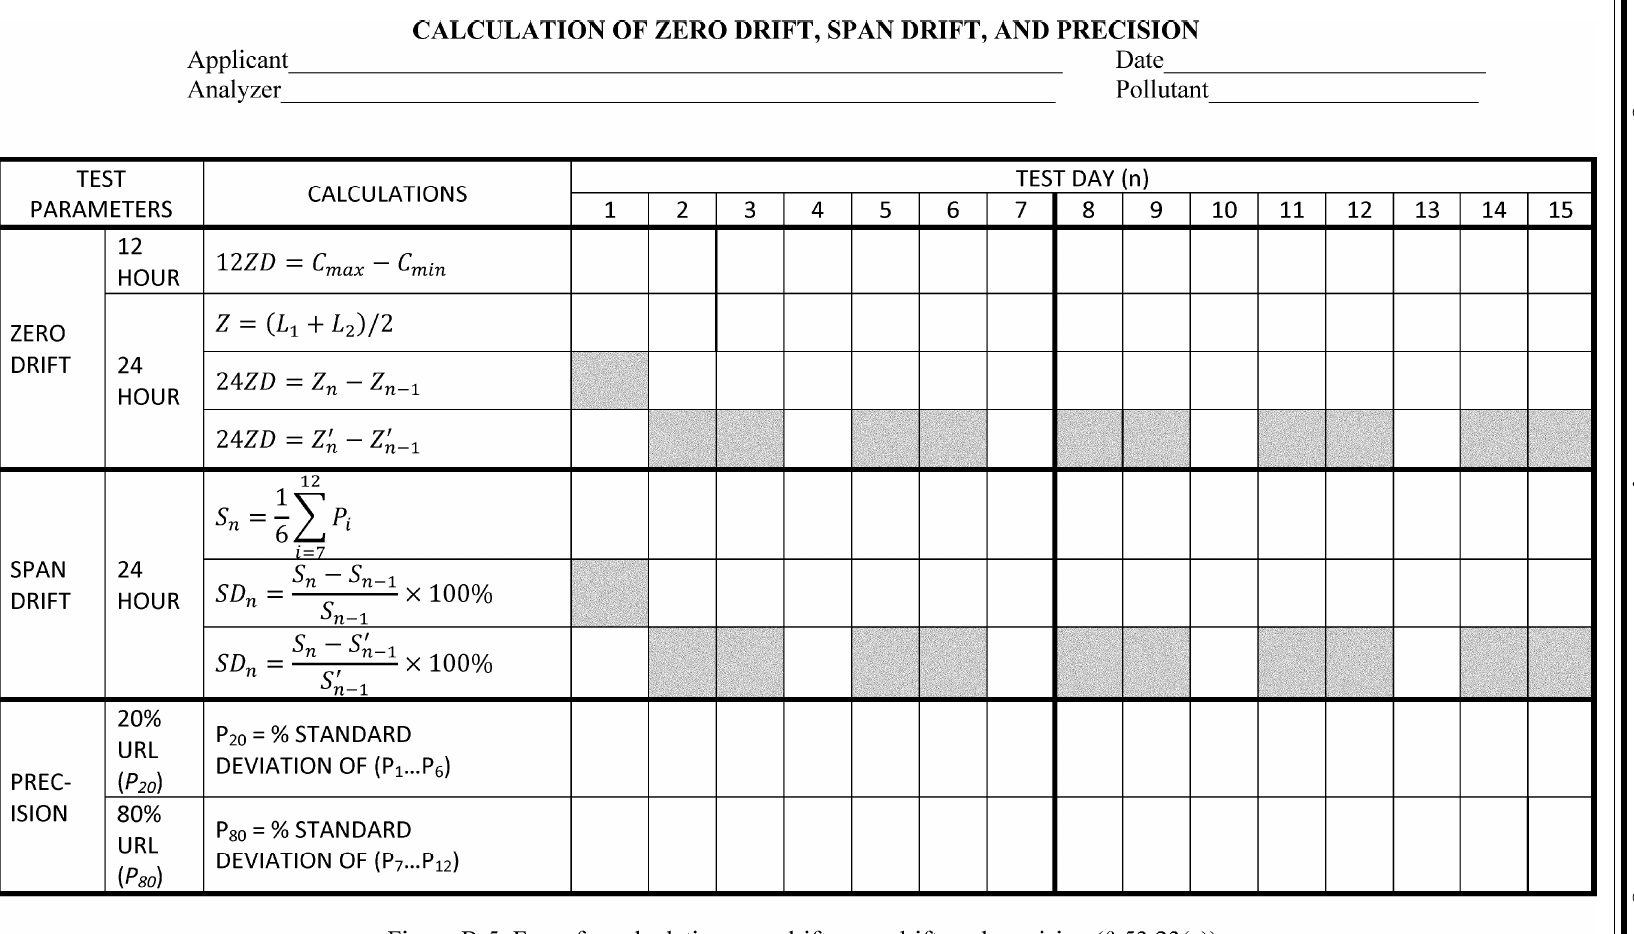
Figure B-5. Form for calculating zero drift, span drift, and precision(§